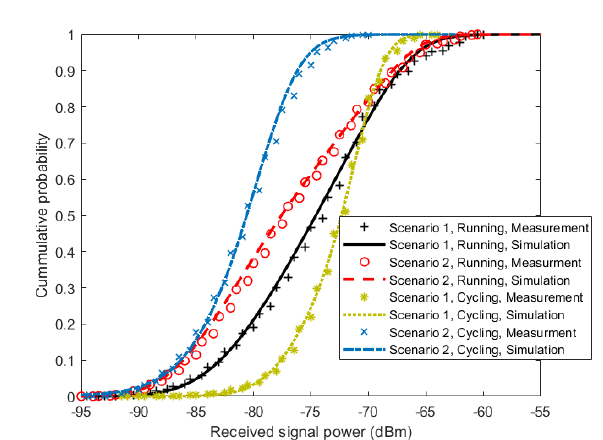
Figure 9. Comparison of cumulative distribution function (CDF) of the measurement results, and the developed simulated model results.